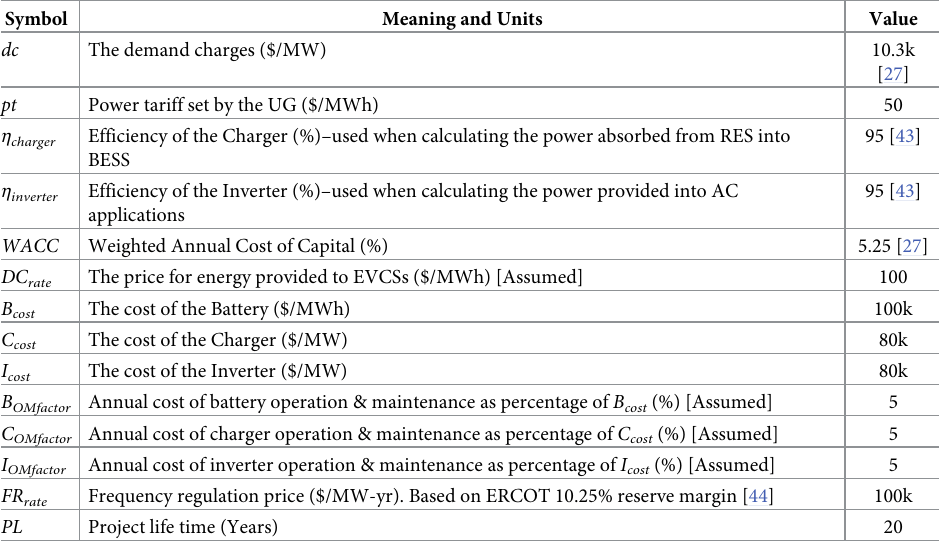
Table 1. Model constants and their values used in this study. Symbol Meaning and